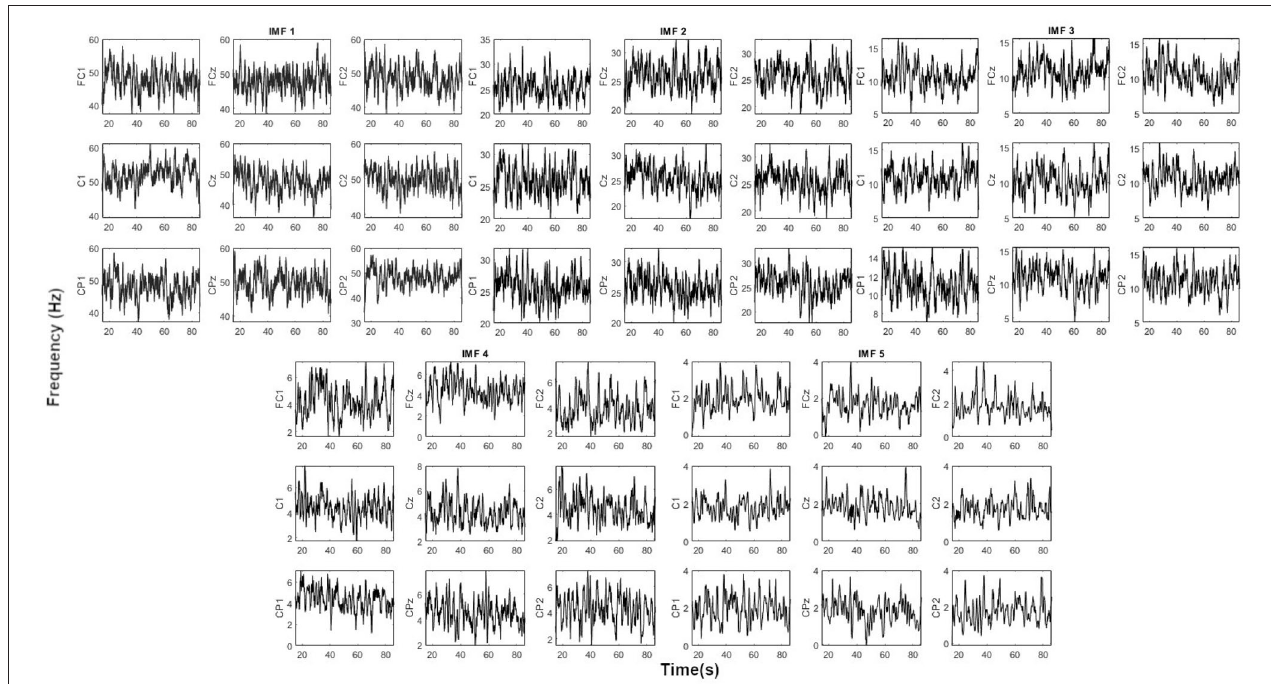
FIGURE 4 | Instantaneous frequency of the first 5 IMFs obtained by EMD of one of the trials of subject S2. Each IMF oscillates within the EEG rhythms: IMF1 (Gamma), IMF2 (Beta), IMF3 (Alpha), IMF4 (Theta), and IMF5